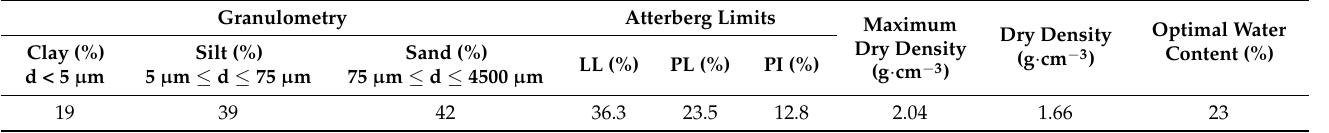
Table 2. Basic physical properties of earth materials.